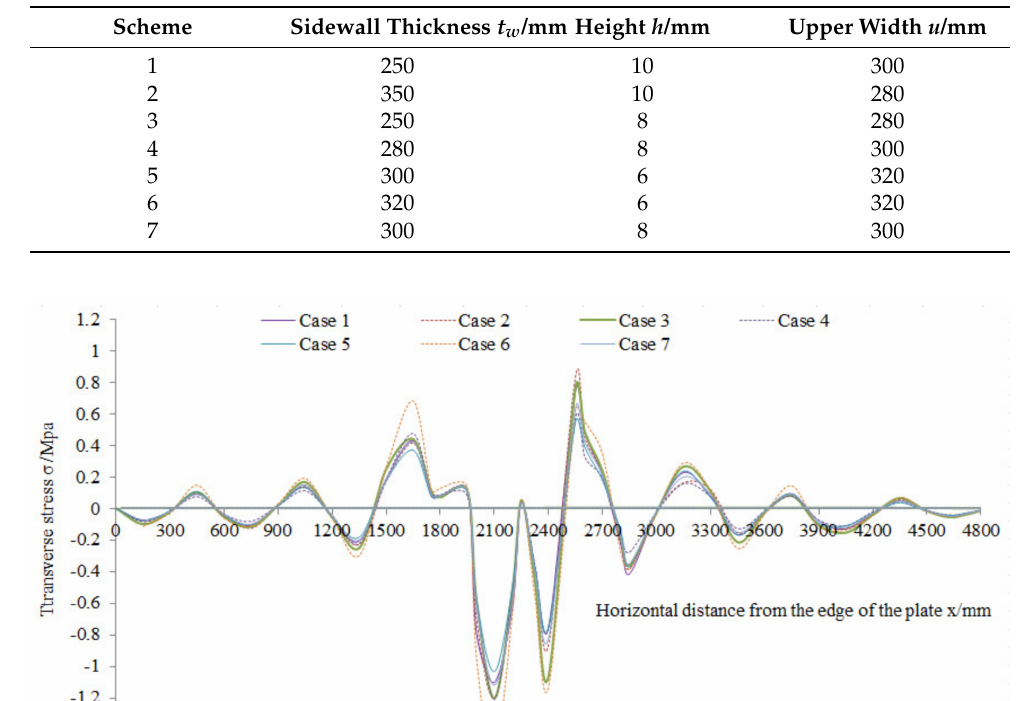
Table 1. Geometric stiffness of longitudinal stiffeners.